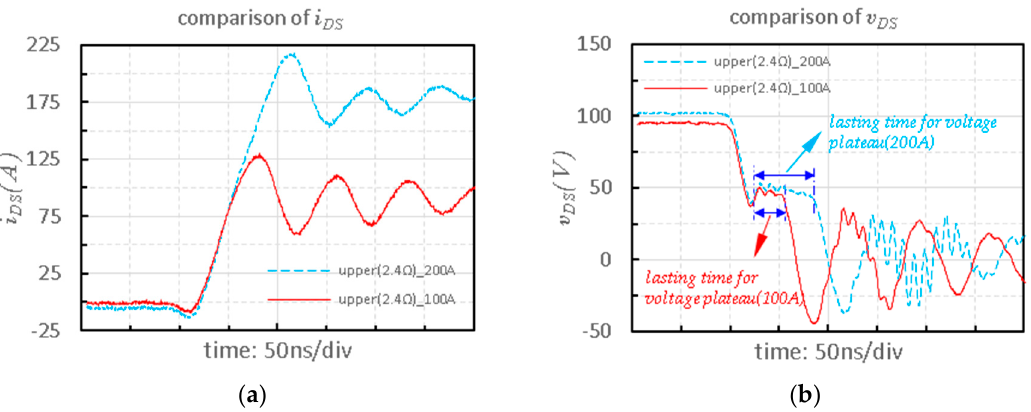
Figure 11. The comparison of turn-on transient waveforms of the module_D with an increased I O under V DD of 100 V: ( a ) waveform of i DS , ( b ) waveform of v DS .